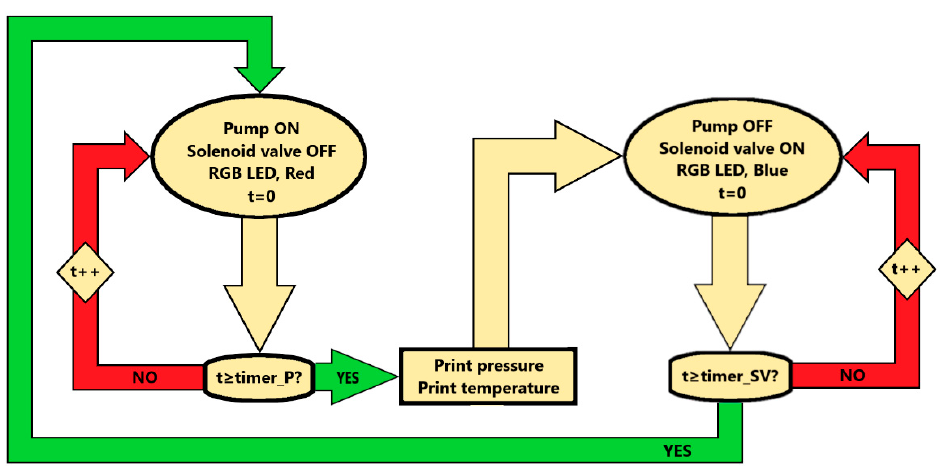
Figure 8. Arduino sketch showing the program loop function.